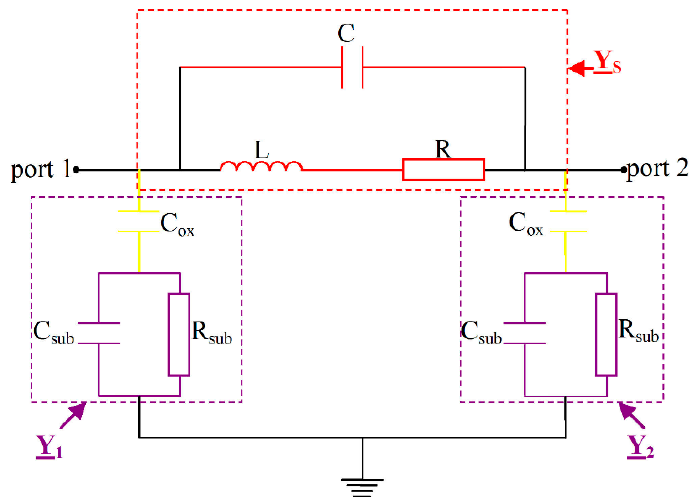
Figure 1. The equivalent circuit for one side of the spiral inductor.